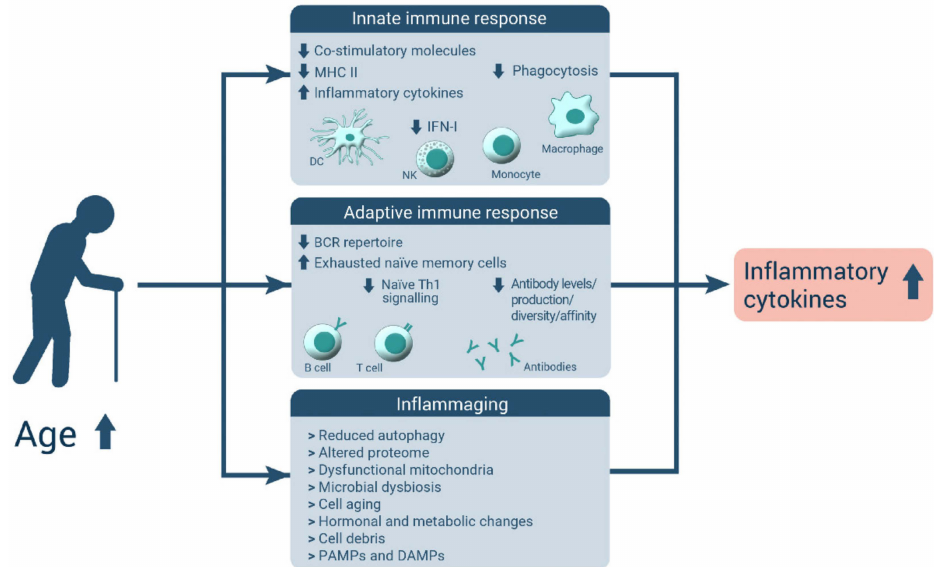
Figure 1. Concept of inflammaging. Due to immunosenescence associated with changes in the innate and adaptive immune response, inflammatory pathways are increasingly activated, leading to a constant low-grade inflammatory state also termed inflammaging (modified after [10]). Abbreviations used: Up-arrow—increased; down-arrow—reduced; MHCII—major histocompatibility complex II; IFN-I—type-I interferon; DC—dendritic cell; NK—natural killer cell; BCR—B-cell receptor; Th1— type 1 T helper cell; PAMPs—pathogen-associated molecular patterns; DAMPs—damage-associated molecular patterns.